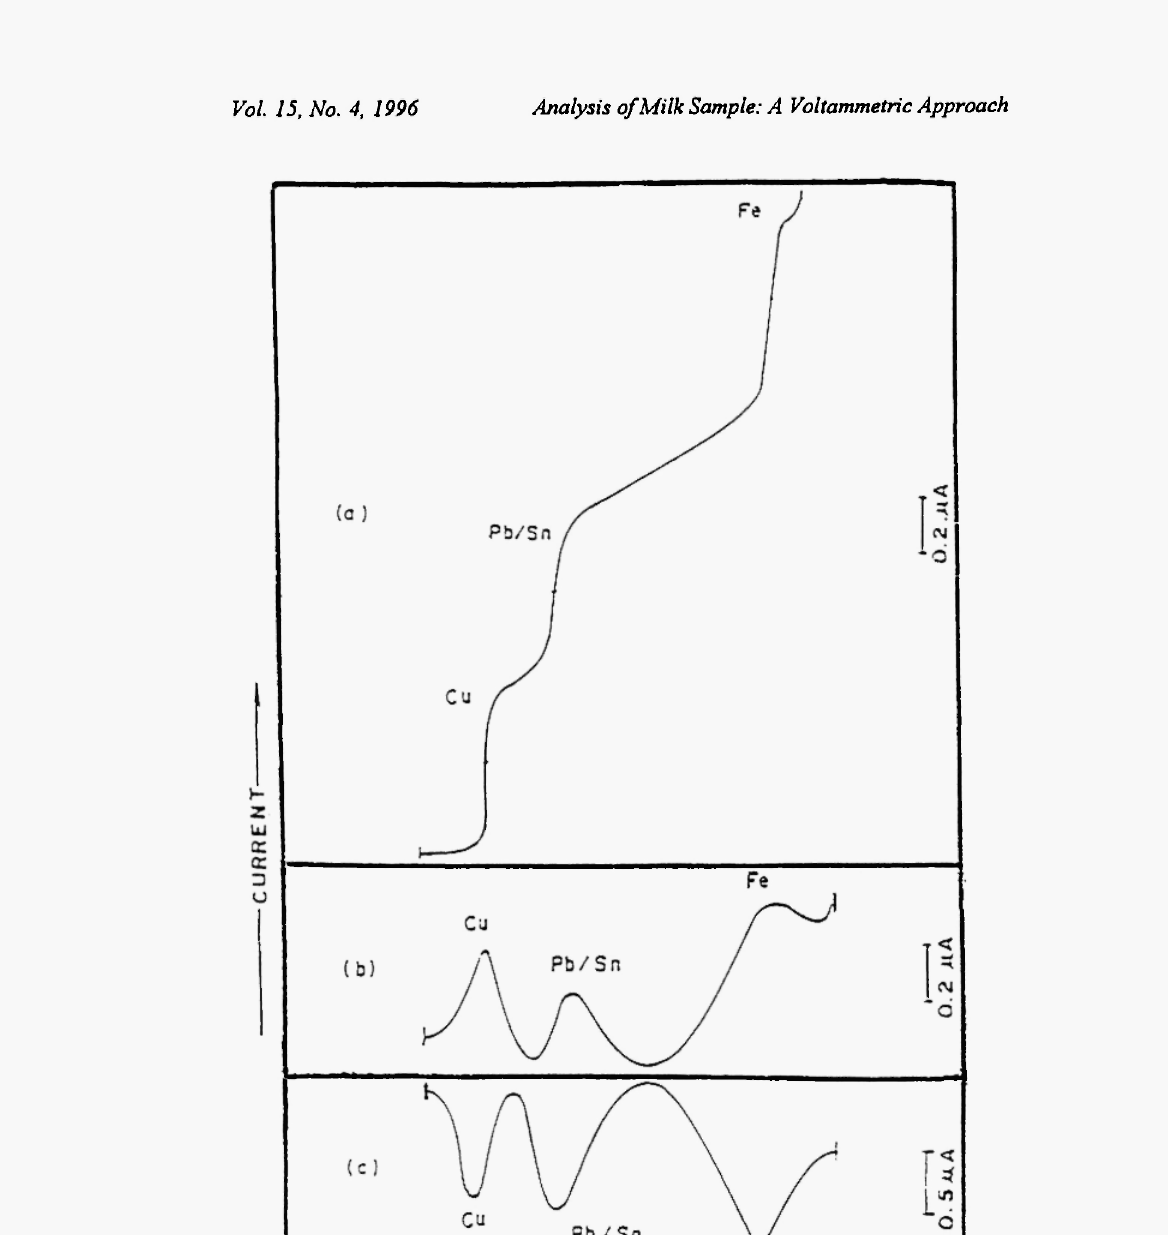
— POTENTiAL — fig. 1. Milk Sample in I % SeignetTe Salt at pH 2.6 ± O.C2 (a)- Direct Current Polarogram I b) -